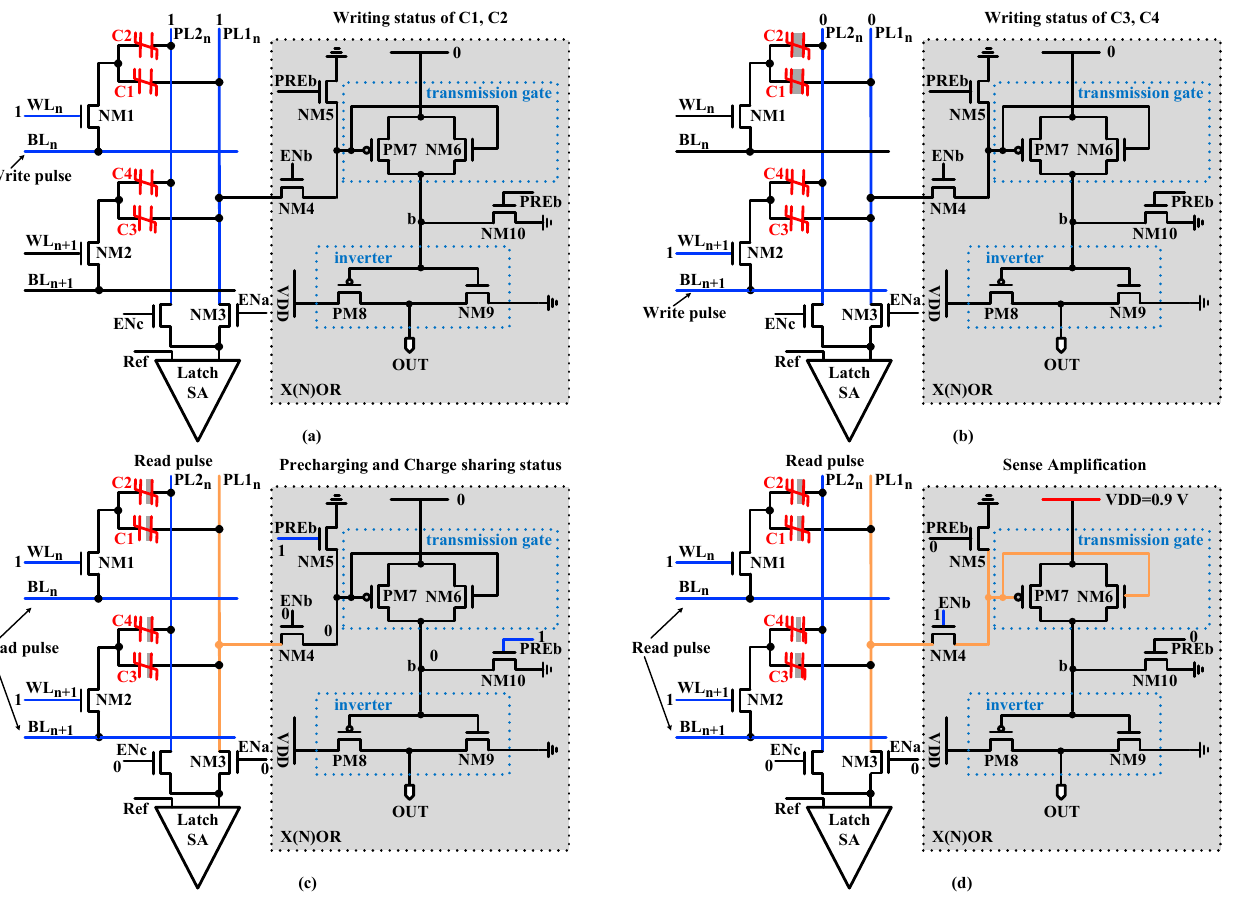
Figure 18. Dual-row activation to realize X(N)OR. ( a ) The writing status of C1 and C2. ( b ) The writing status of C3 and C4. ( c ) Precharging and charge-sharing process. ( d ) X(N)OR readout process. Table 3. The truth table of the in-memory X(N)OR circuit.